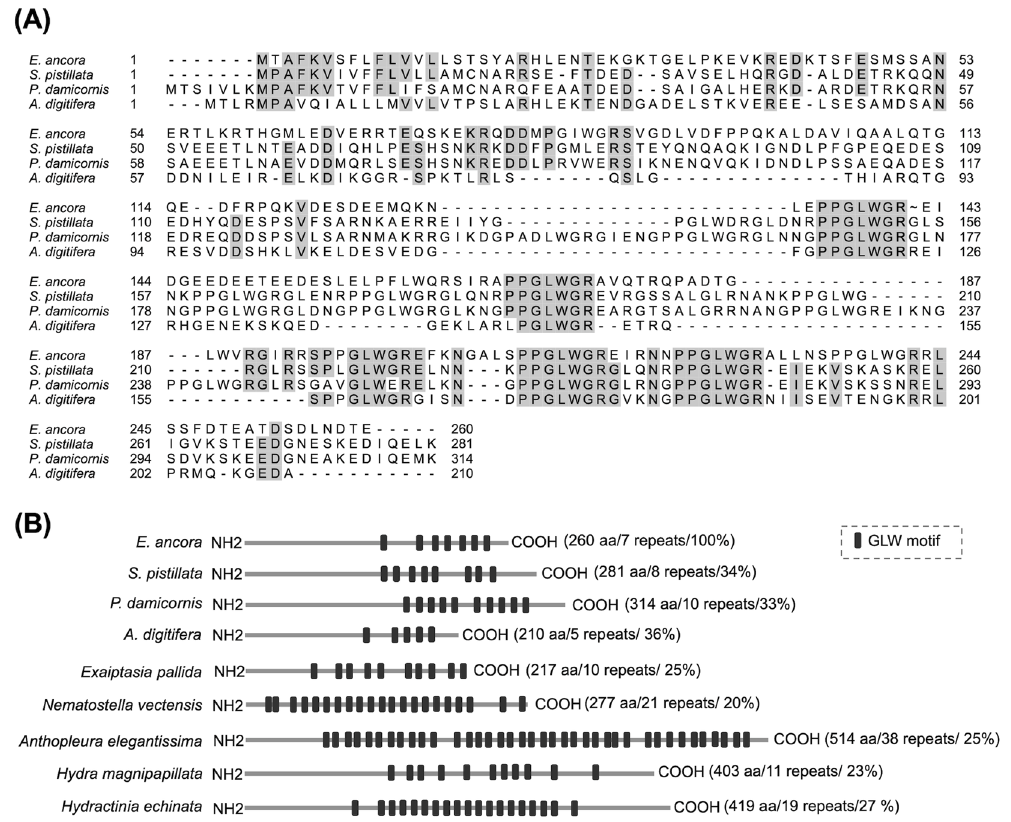
Figure 2. ( A ) Multiple sequence alignments of the deduced amino acid sequences of GLWamide preprohormones from E. ancora (this study, QAU55050), the stony corals Stylophora pistillata (predicted protein, XP_022779355), Pocillopora damicornis (predicted protein, XP_027060554), and Acropora digitifera (predicted protein, XP_015772272). Identical residues are indicated in gray. The identity threshold was set to 75%. Gaps introduced into the sequences to maximize homology are indicated by hyphens. ( B ) Comparison of GLWamide preprohormones among different cnidarians. The lengths, repeat numbers of the GLW motif, and sequence identities of the amino acid sequence of EaGLW preprohormone are shown in parentheses. The position of the GLWamide motif is shown as a black box. In addition to the sequences used in the multiple alignment above, sequences from the sea anemones Exapitasia pallida (predicted protein, KXJ28092), Nematostella vectensis (predicted protein, XM_001626406), Anthopleura elegantissima (Q16992), the freshwater Hydra Hydra magnipapillata (XP_002164748), and the marine hydroid Hydractinia echinata (X89734) were used for the